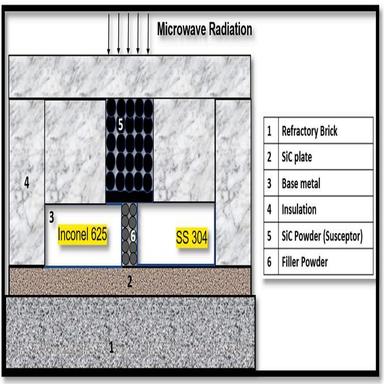
Schematic of SMHJ technique.